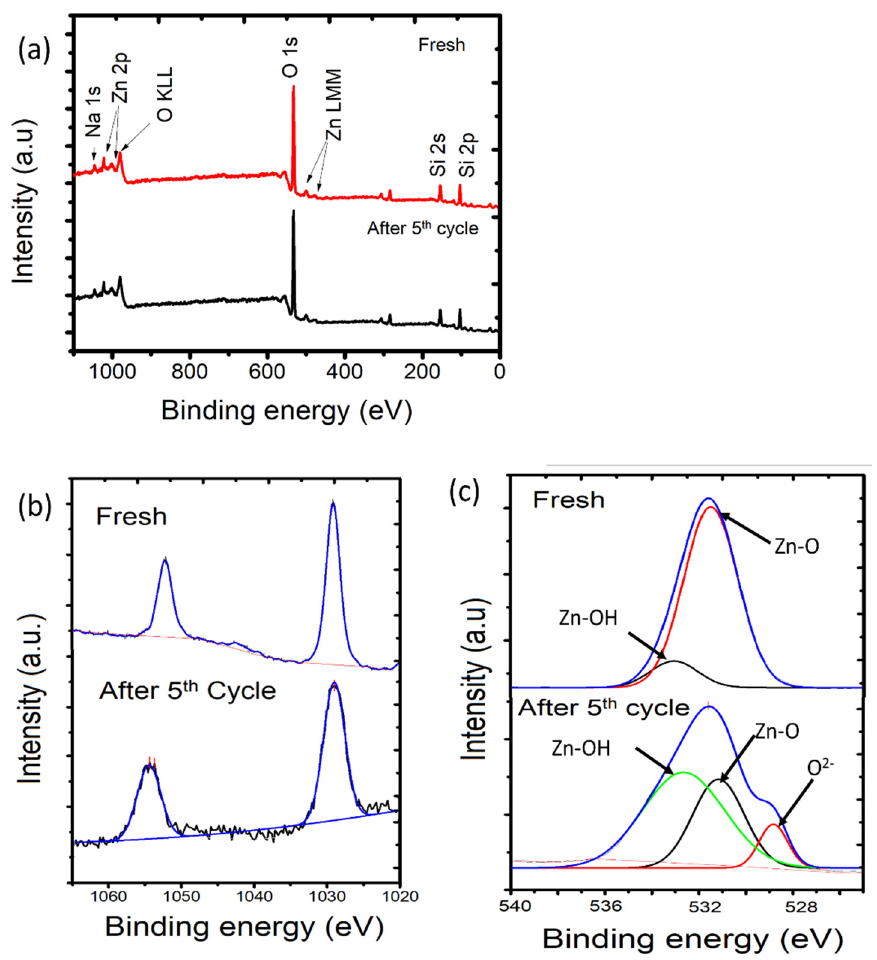
Figure 14. ( a ) Survey scan of PCH15/HT before and after use; ( b ) Spectra of 2p before and after use; ( c ) Deconvoluted O1s peaks before and after use. Table 5. The change of Zn to O ratio of fresh and used PCH15/HT sample.